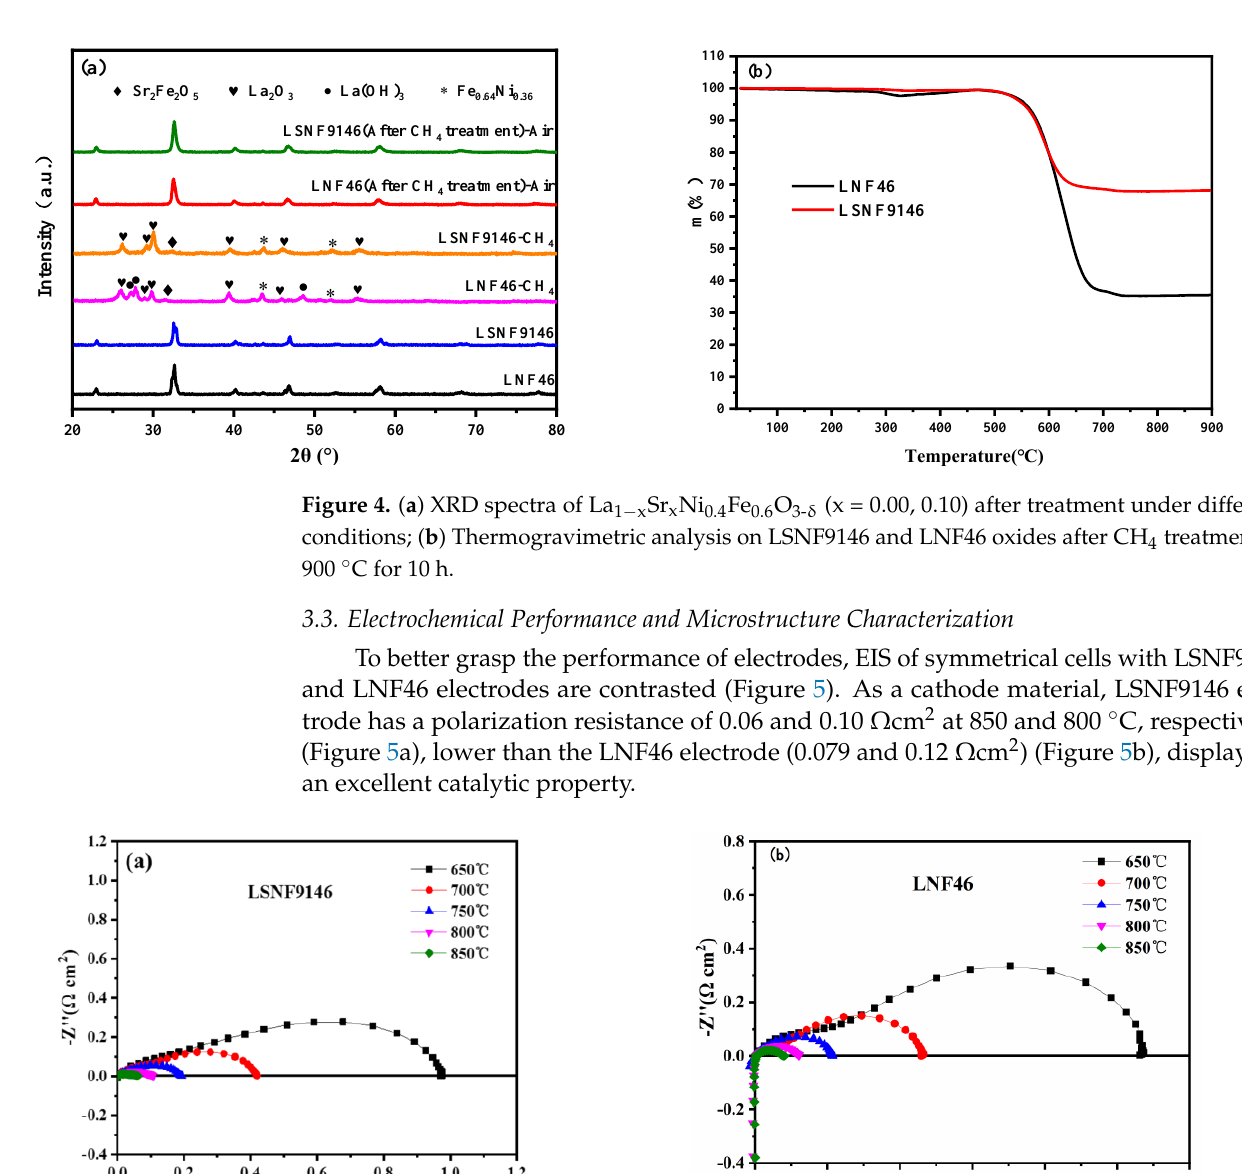
7 of 14 Figure 3. ( a ) Comparison of thermal expansion coefficients of LSNF9146 and SSZ; ( b ) Chemical compatibility between LSNF9146 and SSZ at different sintering temperatures.